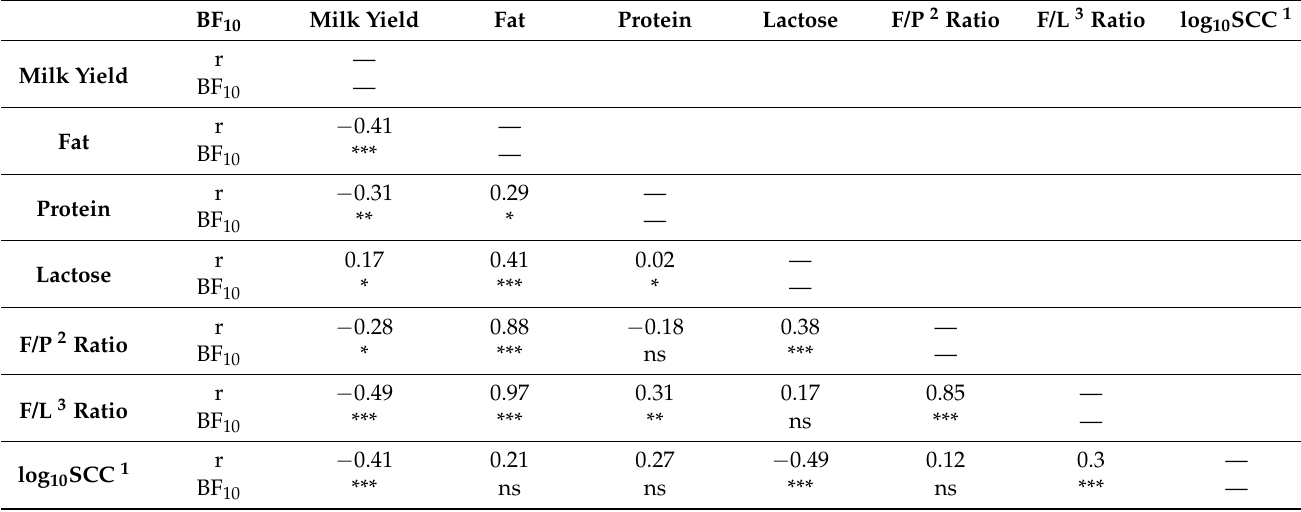
Table 5. Bayesian correlation coefficients for milk variables in Alpine goat breed. Asterisks evidence the significance of BF 10 as reported in the